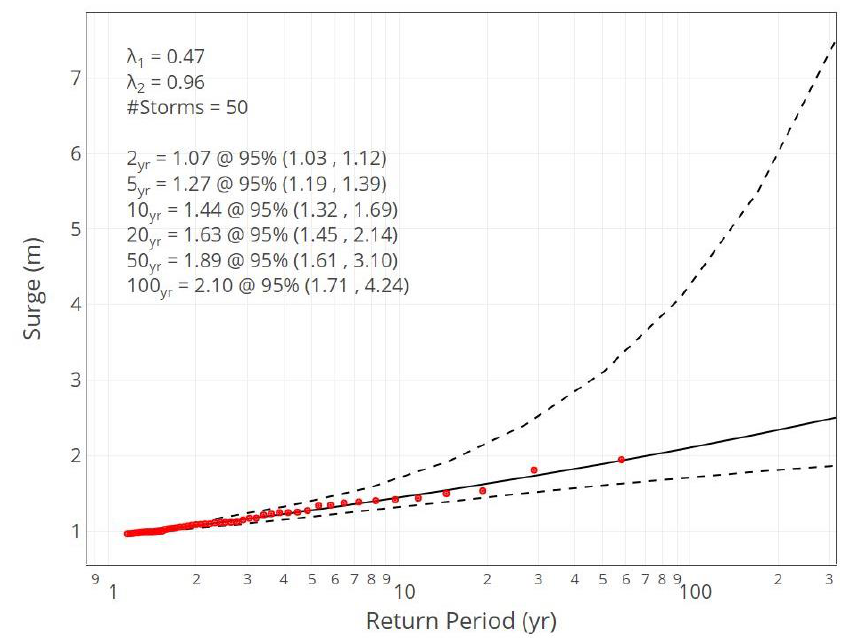
Figure 4. Generalized Pareto Distribution (GPD) fit to the positive water-level residual peaks identified within the Tuktoyaktuk tide gauge record (Station 6485).